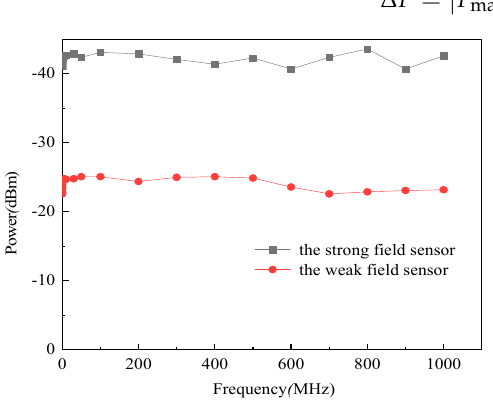
Figure 12. Frequency response of the sensors.